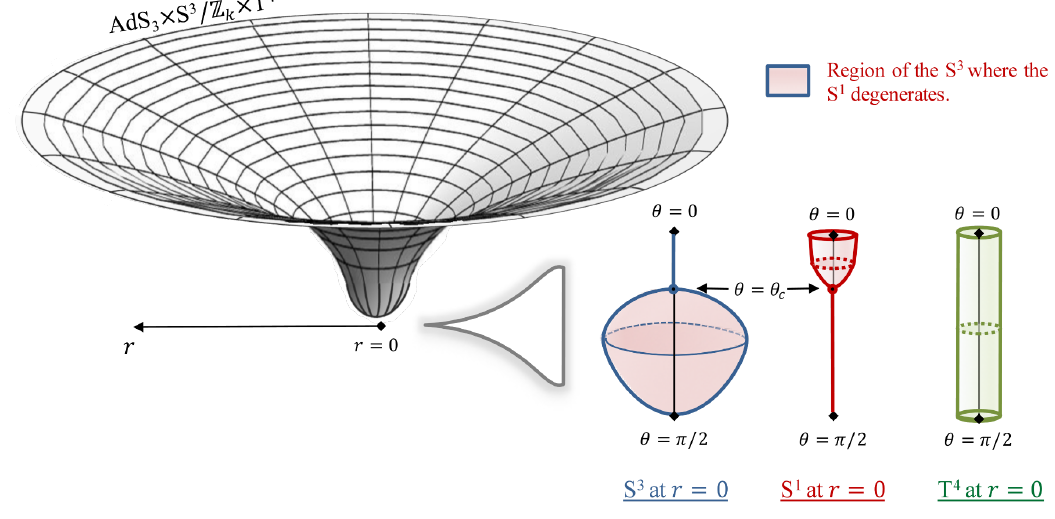
Figure 9 . Schematic description of the spacetime induced by a chain of two rods, forcing the degeneracy of the S 1 and the S 3 Hopf angle ψ = k ( ϕ ) respectively. On the left-hand side, we 1 − ϕ 2 depict the overall geometry in terms of r . On the right-hand side, we describe the behavior of the S 3 , S 1 , and T 4 at r = 0 and as a function of θ